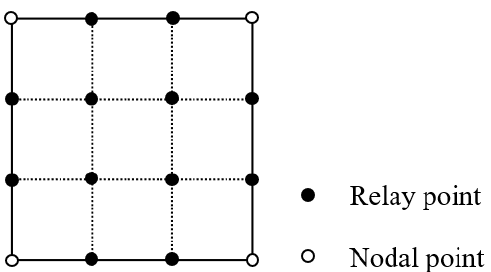
Figure 3. Different rates of the damaged area in the original distribution: ( a ) damage area with 10 cells (10%); ( b ) damage area with 20 cells (20%); ( c ) damage area with 30 cells (30%).